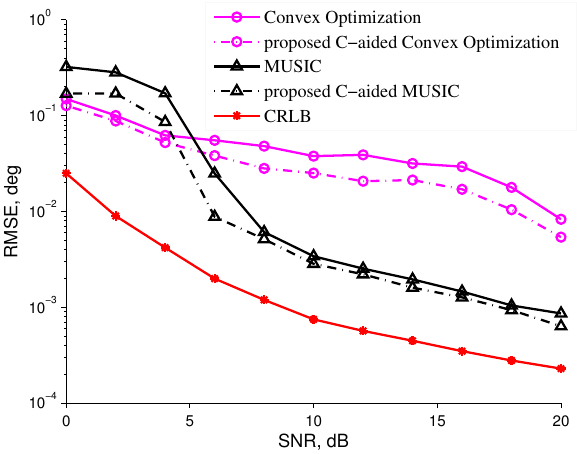
Figure 3. RMSE of DOA estimation algorithms against SNR ( M AI = M AII =